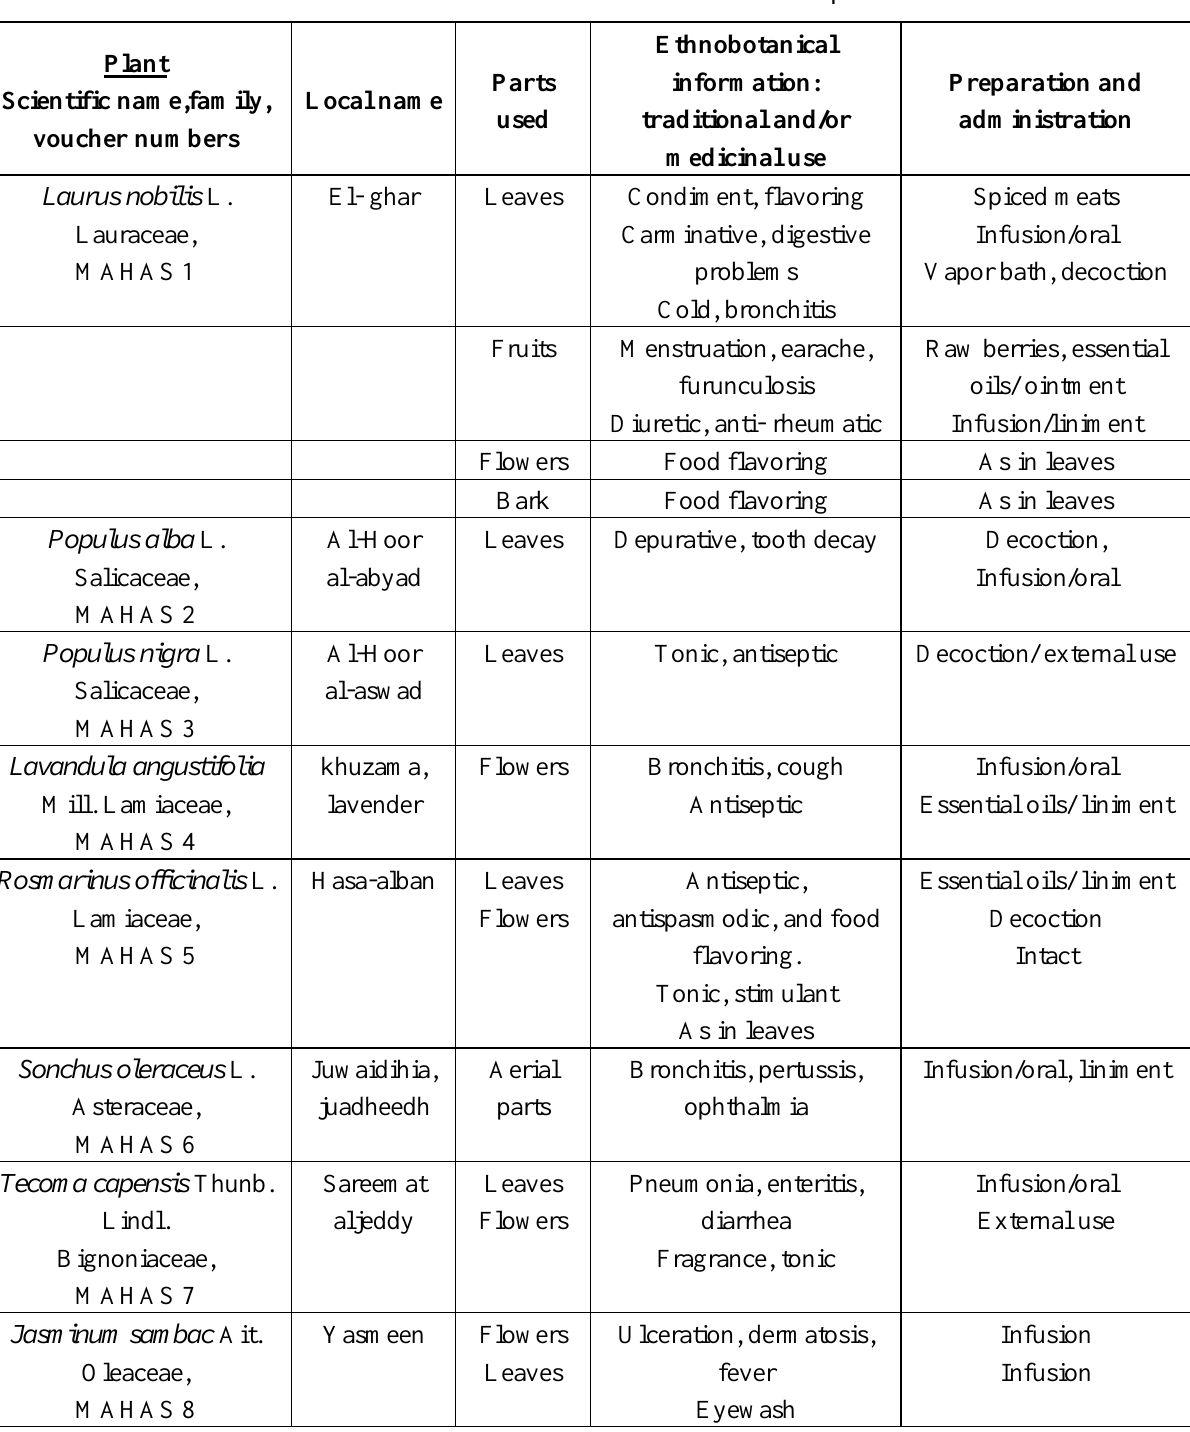
Table 1. Ethnobotanical data about the studied